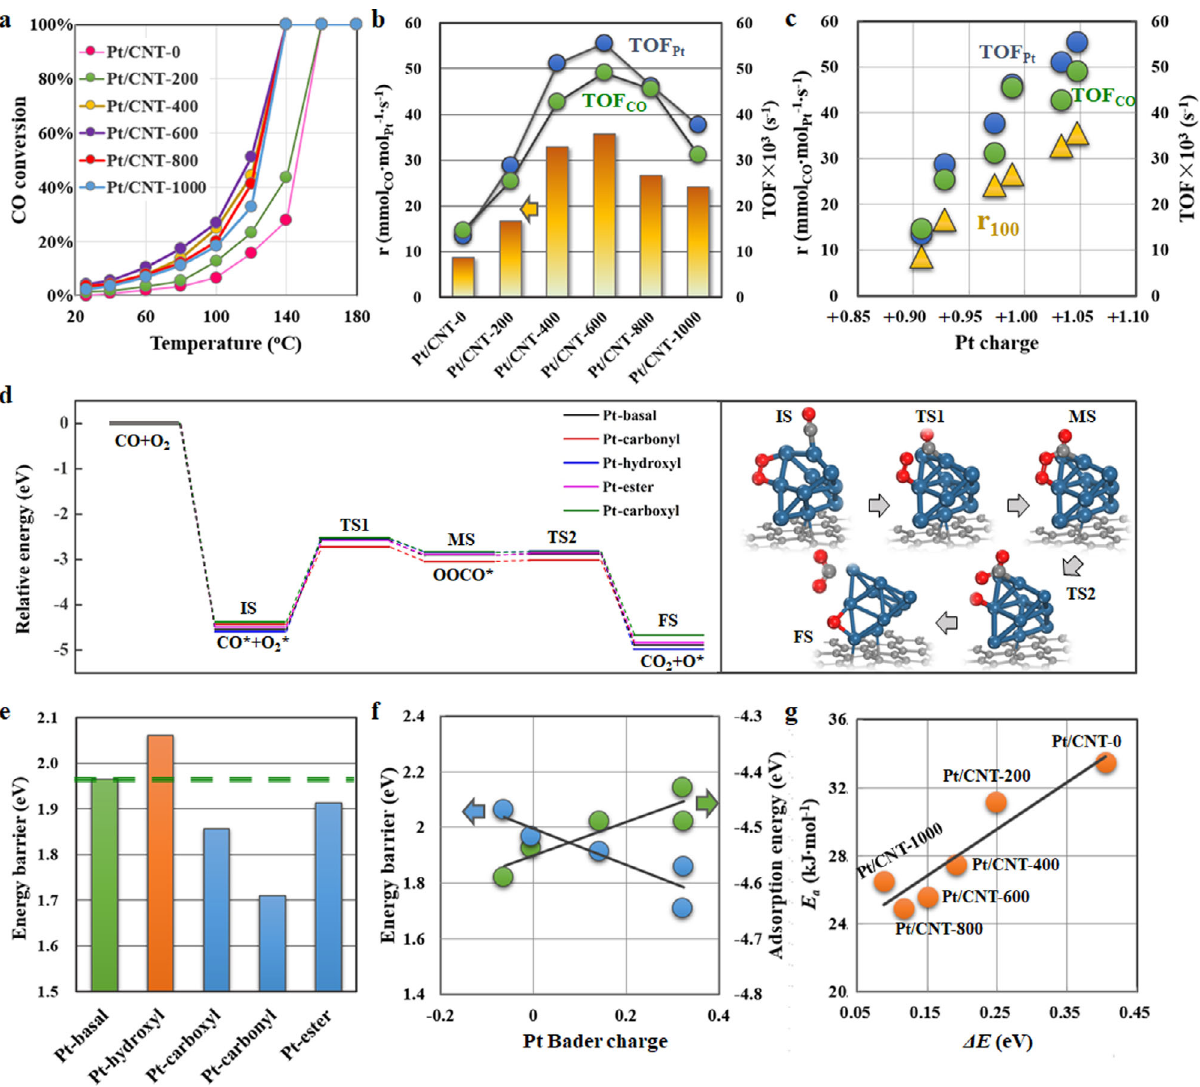
Fig. 3 Catalytic testing and DFT calculations of CO oxidation. a CO conversion as a function of temperature. The reaction rate (r 100 ) and the corresponding TOF Pt and TOF CO at 100 °C ( b ), as well as the relationships between r 100 , TOF Pt , TOF CO and Pt charge ( c ), for Pt/CNT-0, Pt/CNT-200, Pt/ CNT-400, Pt/CNT-600, Pt/CNT-800 and Pt/CNT-1000. Potential energy diagram from DFT calculations and the schematic diagram of the related con fi gurations over Pt-basal ( d ), and the corresponding energy barrier ( e ) for CO oxidation over Pt-basal, Pt-hydroxyl, Pt-carboxyl, Pt-carbonyl, and Pt- ester. f The relationships between energy barrier ( Δ E i ), adsorption energy ( E ads ) and Pt Bader charge. g The relationship between the activation energy ( E a ) and the proposed energy barrier ( Δ E ), incorporating the in fl uences of the above OCGs (Supplementary Information), for Pt/CNT-0, Pt/CNT-200, Pt/CNT- 400, Pt/CNT-600, Pt/CNT-800, and